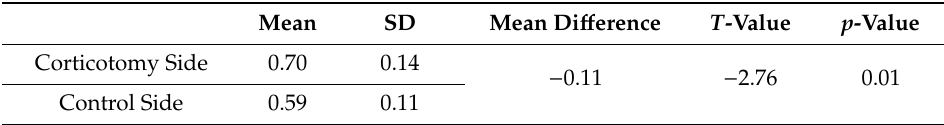
Table 1. Comparison of the rate of canine retraction at the partial corticotomy side (upper right side) and the control side (upper left side).